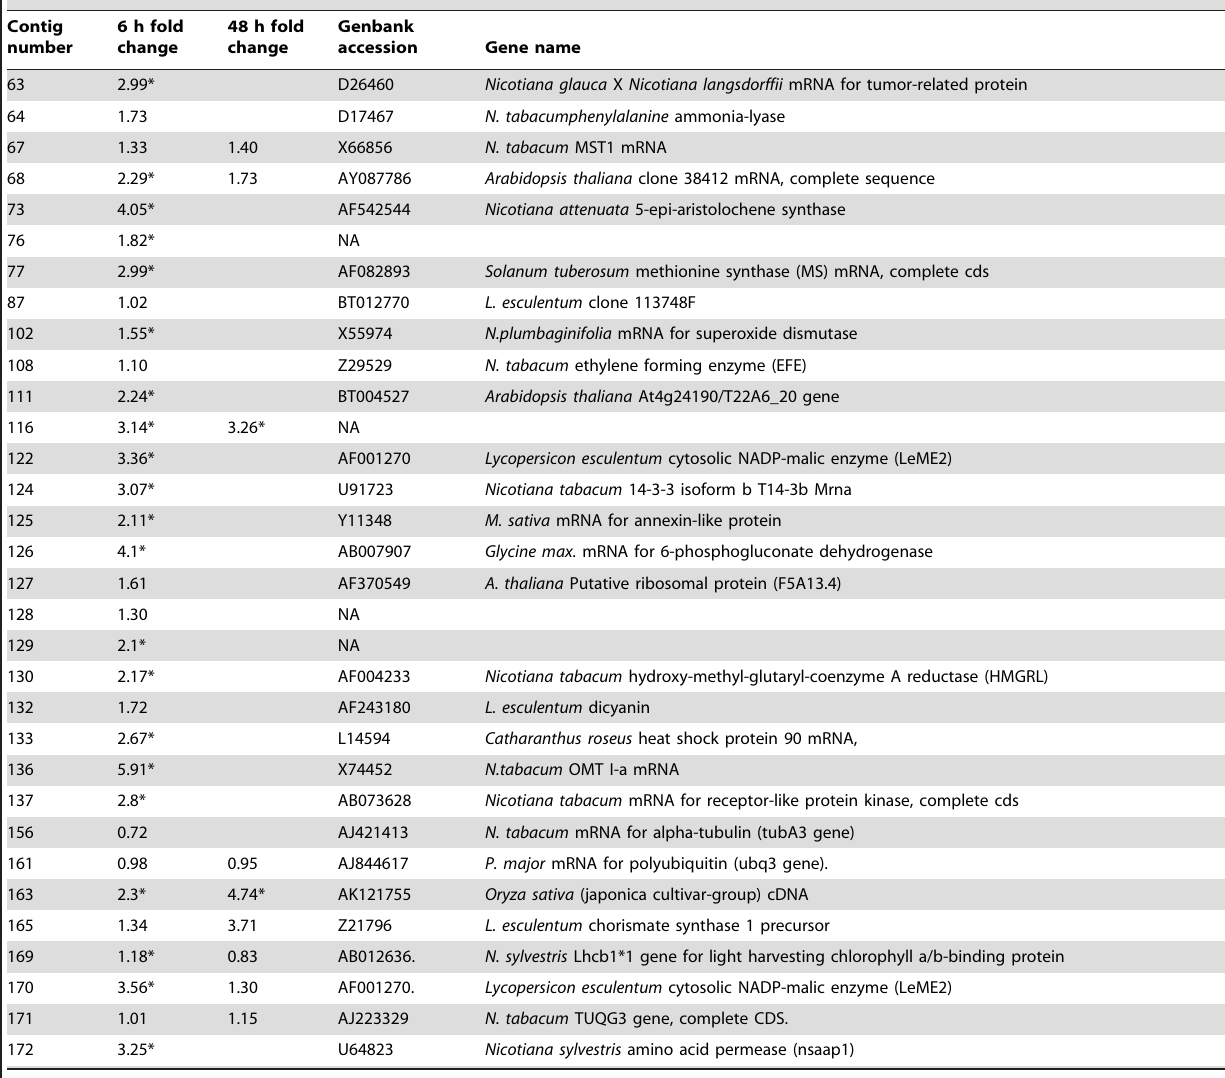
Linear fold changes of PTI-related genes at 6 and 48 hpi measured by microarray Contig number